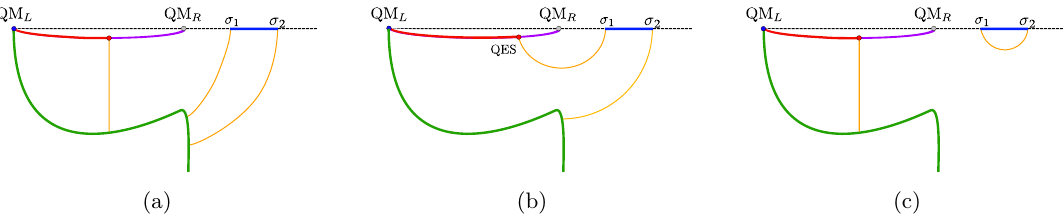
Figure 11. HRT geodesic configurations that can compute the matter part of the generalized entropy at intermediate times. (a) CrossDisconnected saddle, (b) ScramblingTrivial and LateTrivial saddles (differing by the position of QES with respect to the shock, not shown), (c) CrossConnected saddle. The red region of the Planck brane is reconstructable by R ∪ QM L when the corresponding saddle